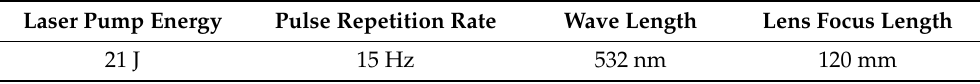
Table 1. Experimental parameters of the